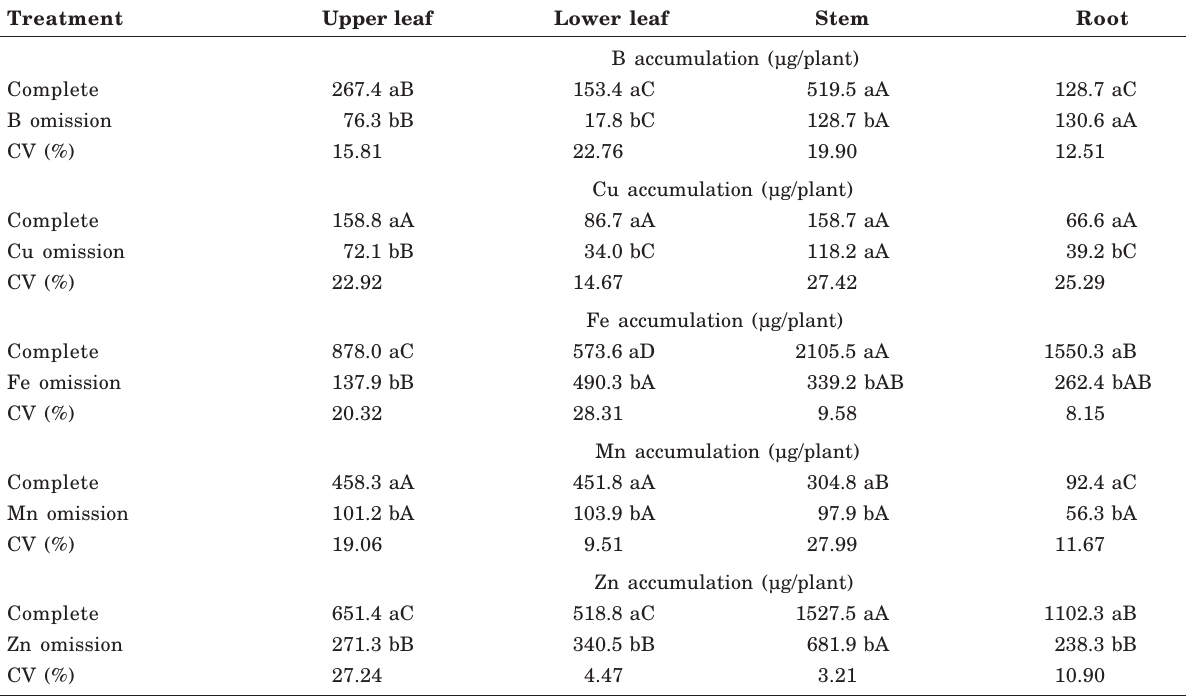
Means followed by the same upper-case letter in rows and lower-case letter in columns are not significantly different by Tukey’s test at